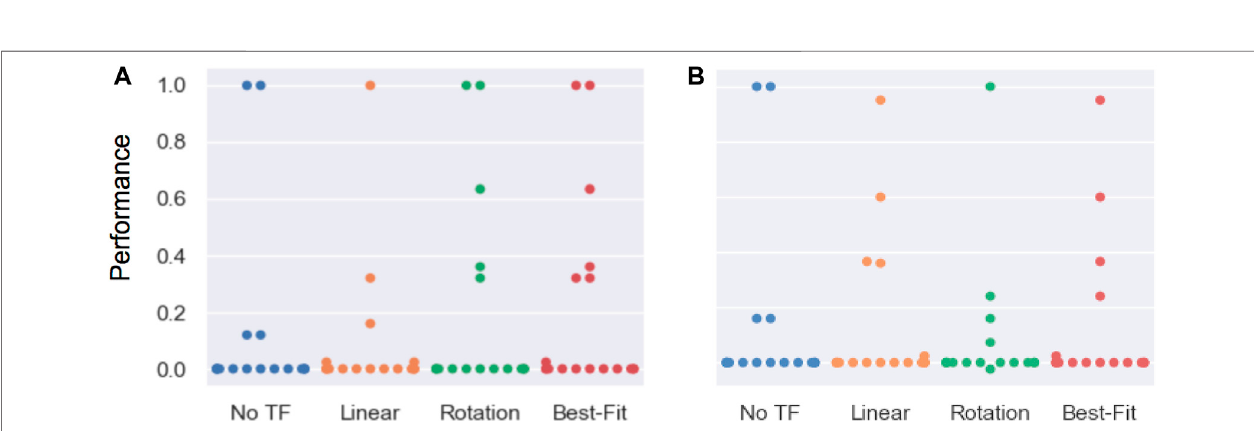
FIGURE13| Meanperformanceof (A) within-taskand (B) across-tasktransfertothebrushandmugreplacementtoolsoverall18transferexecutionsforeachtool. (C) Mean performance of across-task transfer to the brush and mug replacement tools over the subset of transfer executions in which the transformation between sourceandcorrectiontasksissimilarforthesourceandreplacementtool(10executionsforthebrush,12forthemug).Darkercellsindicatehigheraverageperformance.